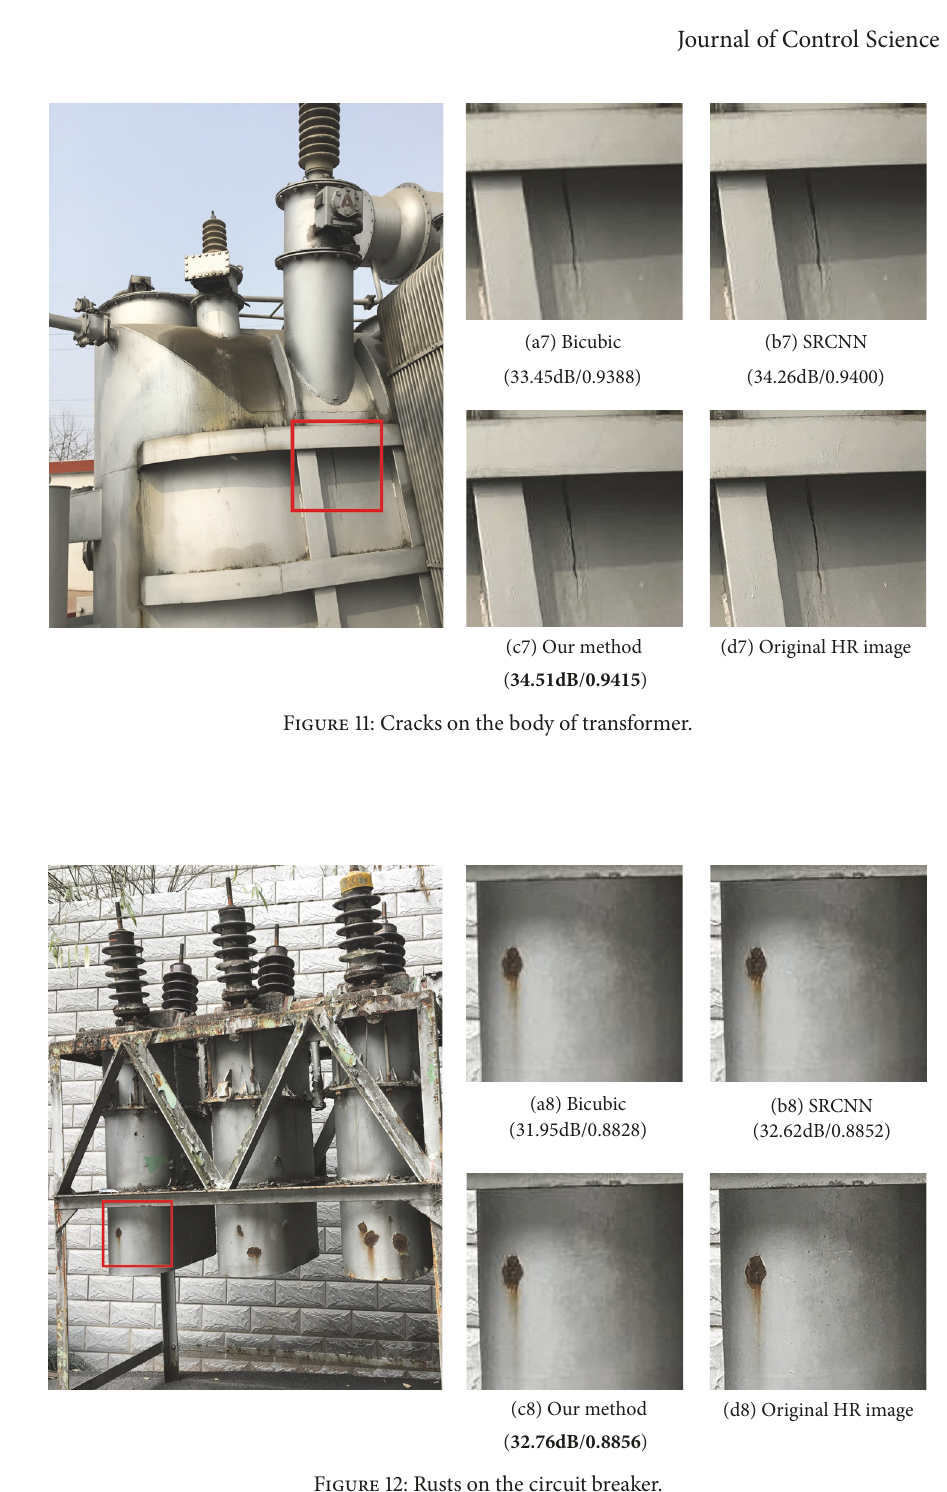
Figure 12: Rusts on the circuit